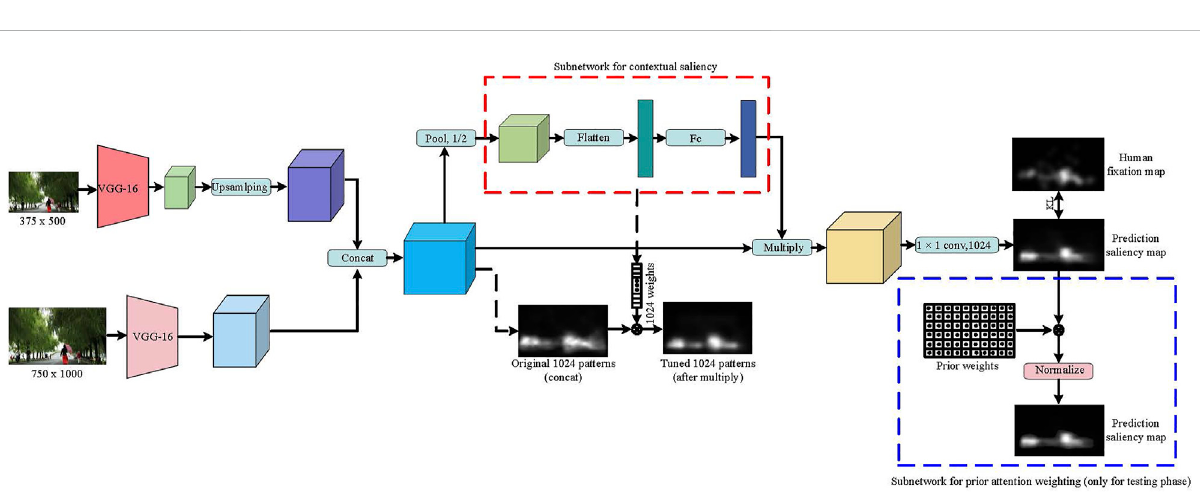
FIGURE 4 The architecture of the proposed APNet. Two-stream consists of two VGG-16 models which operate on coarse and fi ne-grained scales of an images. To capture the relative importance of the semantic features of a particular image, a channel-weighted subnetwork (inside the dashed red rectangle) wasdesigned tocomputeasetof1024-dimensionalfeaturesfor eachimage. Theprioriattention weighting subnetwork(the bluedashed rectangle)directly weightstheprediction saliency mapoutputbytheDNN,whichweightsthecombines thehumaneye ’ sperceptionsensitivity to color, and can achieve a saliency prediction closer to human visual